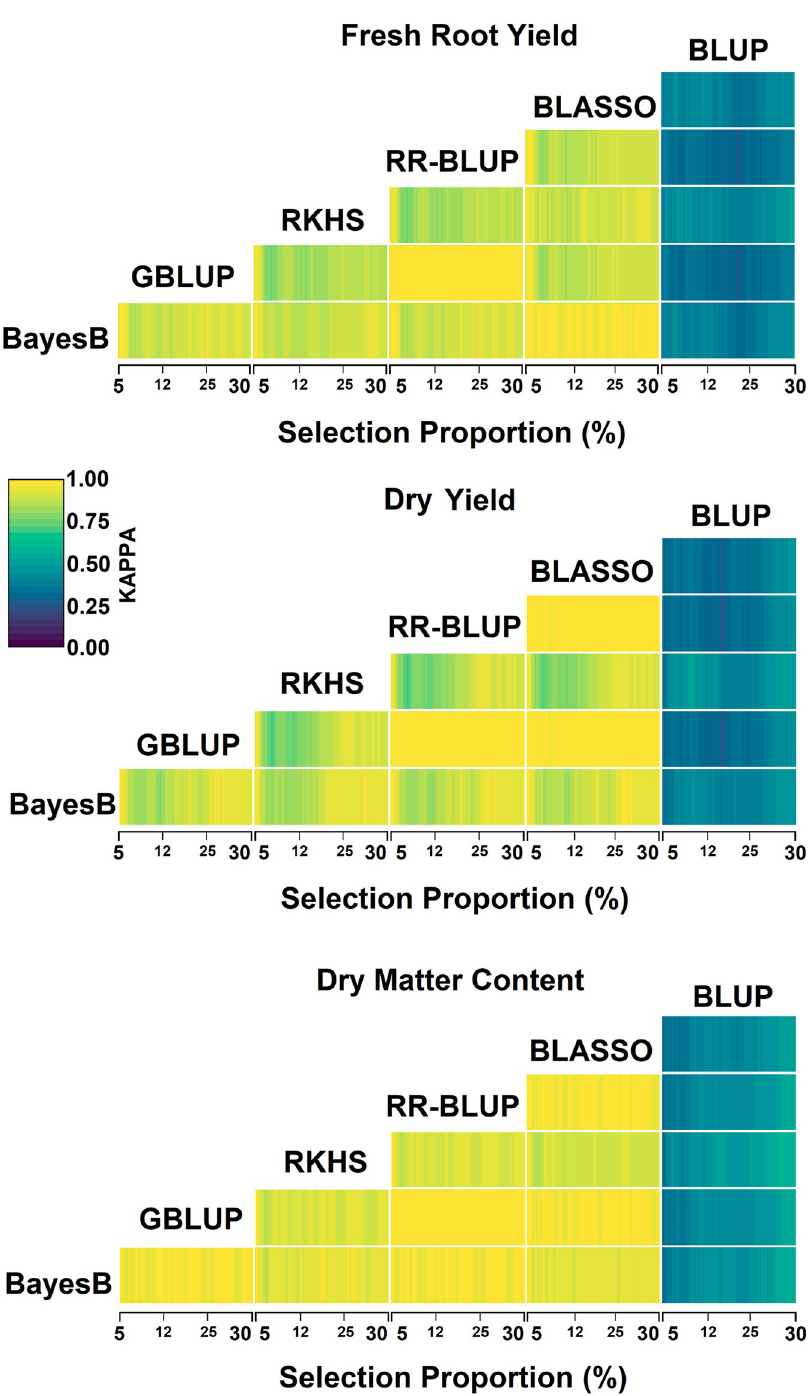
Fig 4. Cohen’s Kappa for the selection coincidence of higher GEBV cassava genotypes, considering selection proportion (5% to 30%—SP) with the 1 st cross validation strategy of different genomic selection methods BayesB, BLASSO, G-BLUP, RR-BLUP, RKHS and phenotypic REML/BLUP, for fresh root yield, dry root yield and dry matter content.